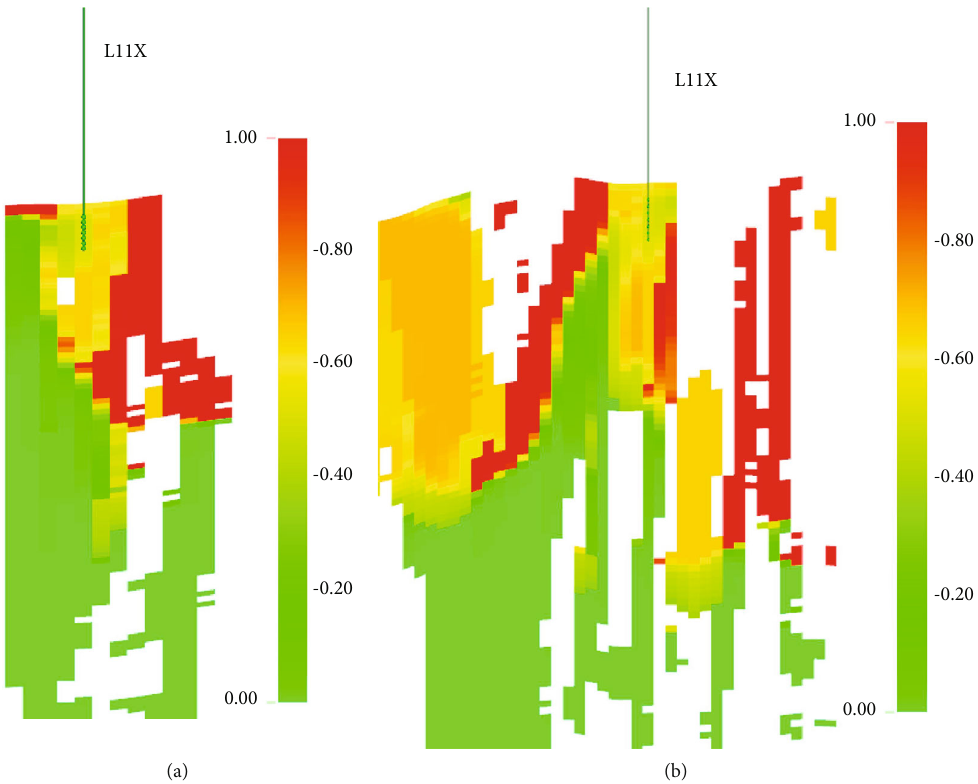
Figure 10: Residual oil distribution characteristics of the L11X